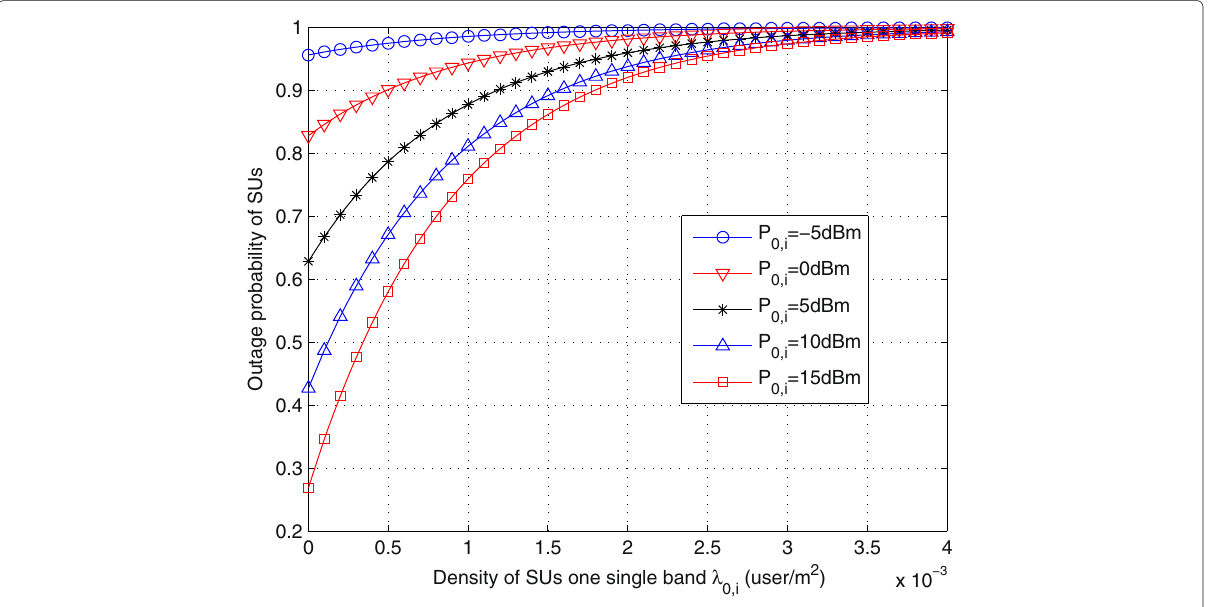
Fig. 2 Outage probability of SUs vs. density of SUs on one single band